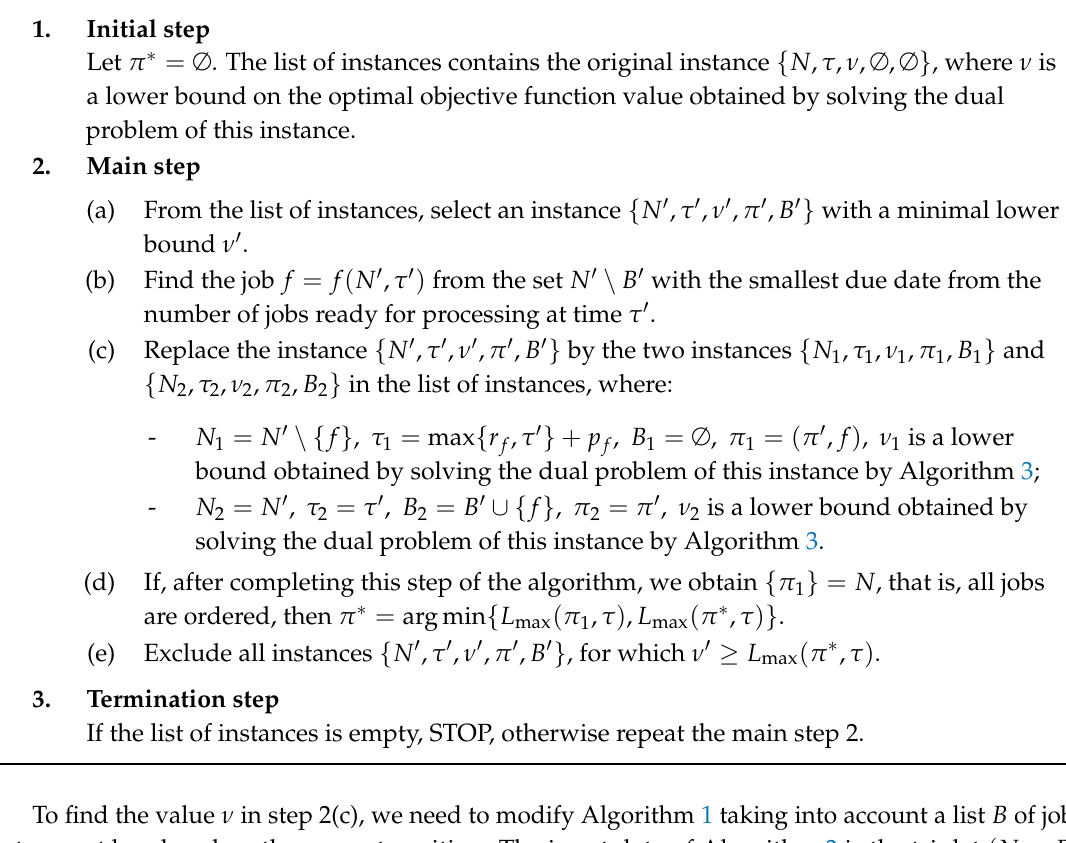
Algorithm 2: Solution of the problem 1 | r j | L max by the branch and bound method based on the solution of the dual